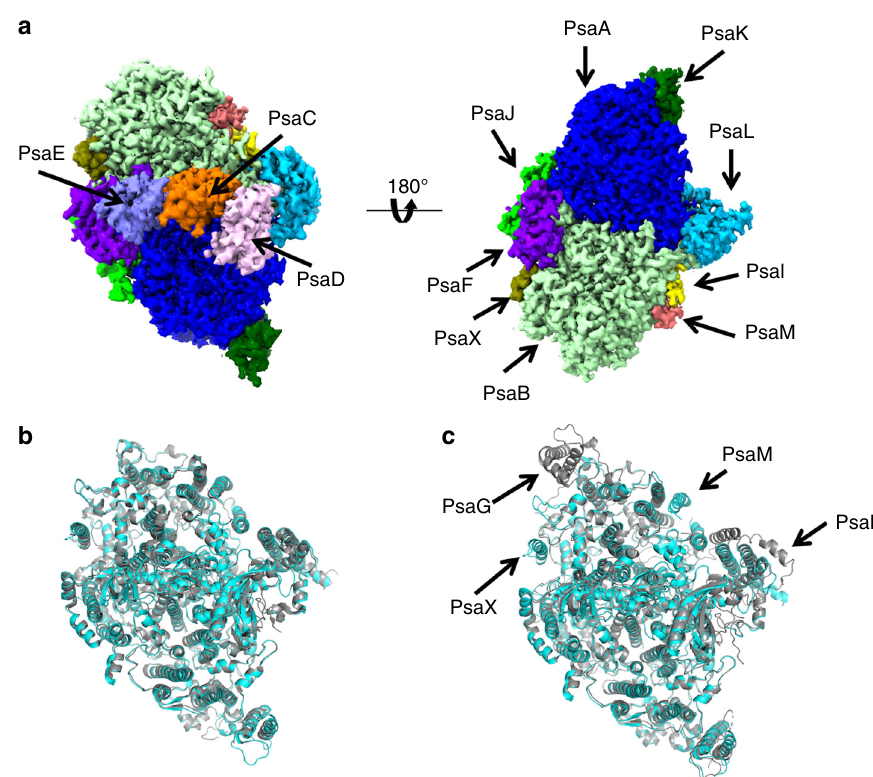
Fig. 2 Structure of a PSI monomer. a The 3D map of a PSI monomer viewed along the membrane normal from the stromal (Left) and lumenal sides (Right). b Superposition of an Anabaena PSI monomer (cyan) with a T. elongatus PSI monomer (gray) viewed along the membrane normal from the stromal side. c Superposition of an Anabaena PSI monomer (cyan) with a P. sativum PSI monomer (gray) viewed along the membrane normal from the stromal side. The subunits speci fi c to each organism are